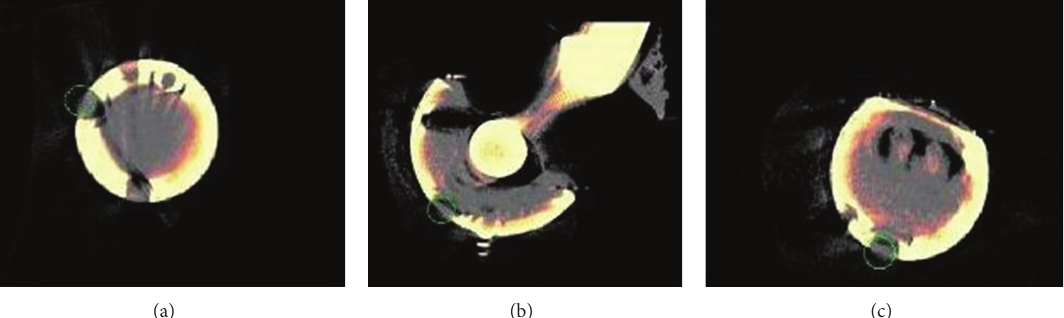
Figure 1: Three 2D orthogonal projections showing the 3D spherical landmark located in the apical dome hole. (a) shows the axial projection, (b) the coronal, and (c) the sagittal.